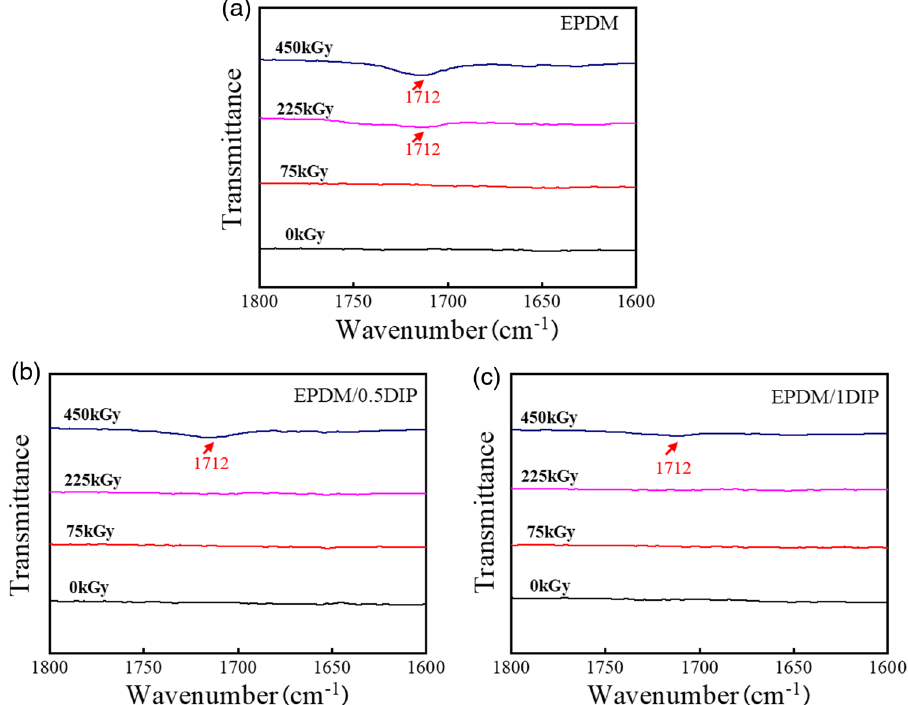
Fig. 2 ATR FT-IR spectra of the EPDM and EPDM/DIP blends at different γ -irradiation doses. a EPDM, b EPDM/0.5DIP blend, c EPDM/ 1DIP